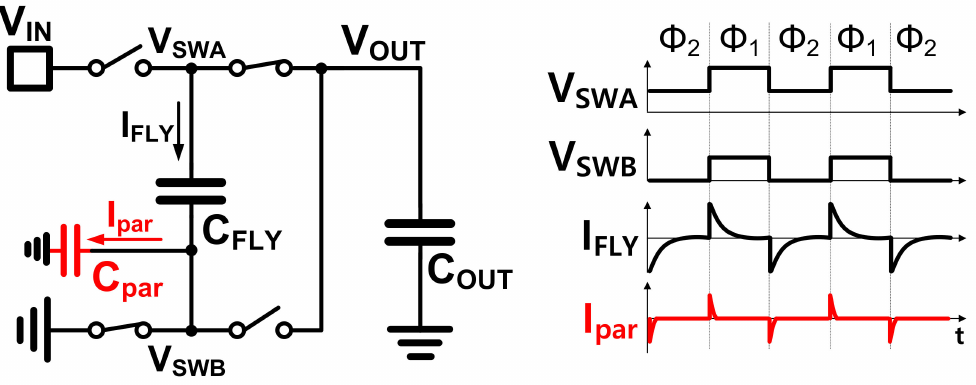
Figure 1. 2:1 SC DC-DC converter with the parasitic capacitor of a flying capacitor, C FLY